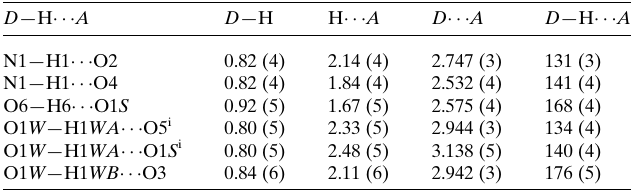
Table 1 Hydrogen-bond geometry (A˚ , (cid:4)